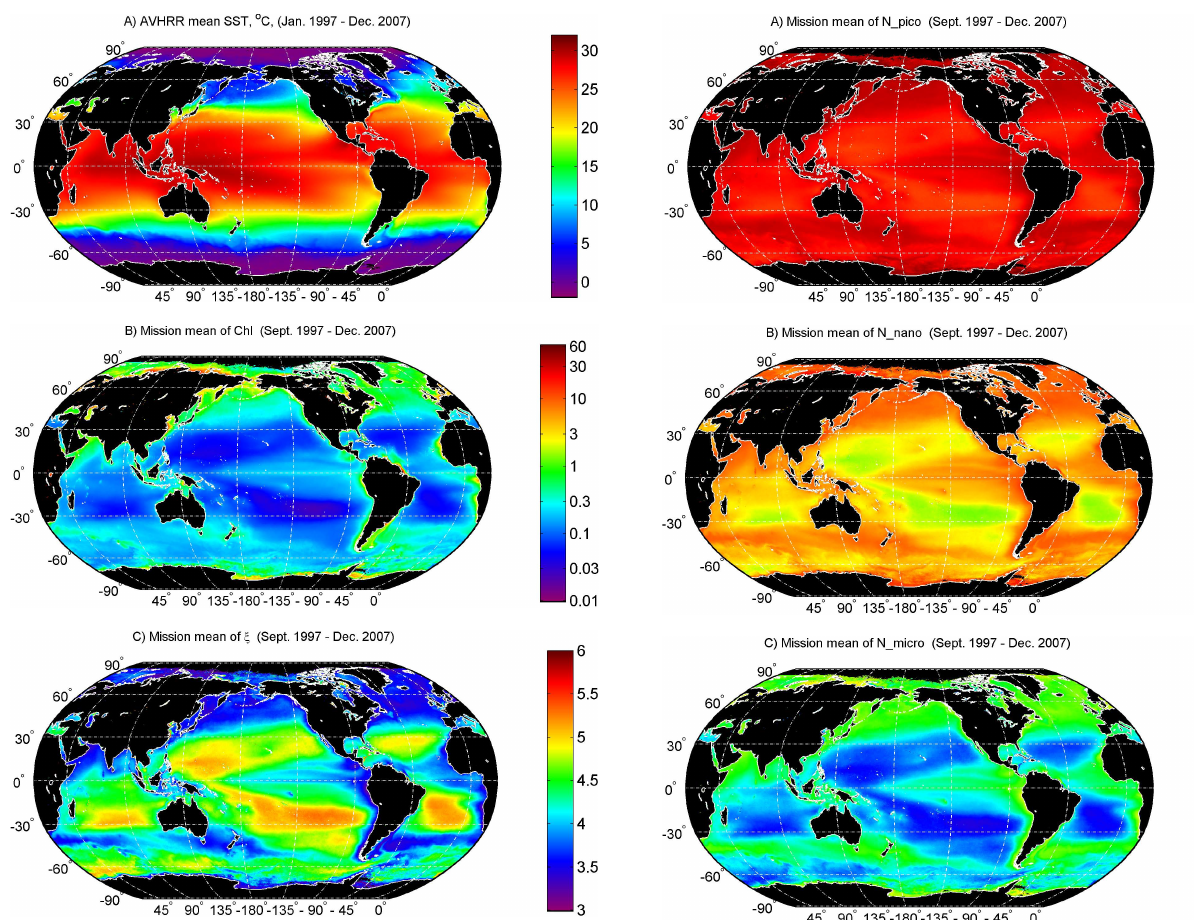
Fig. 5. SeaWiFS mission mean (Sep 1997–Dec 2007) maps of the number concentration (in particles per m 3 of seawater in log10 space) of (A) picoplankton-sized particles (0.5–2µm), (B) nanoplankton-sized particles (2–20µm), and (C) microplankton- sized particles (20–50µm). Number concentrations were calculated from the PSD parameters ξ and N 0 (see Eq. 5 in Kostadinov et al.,